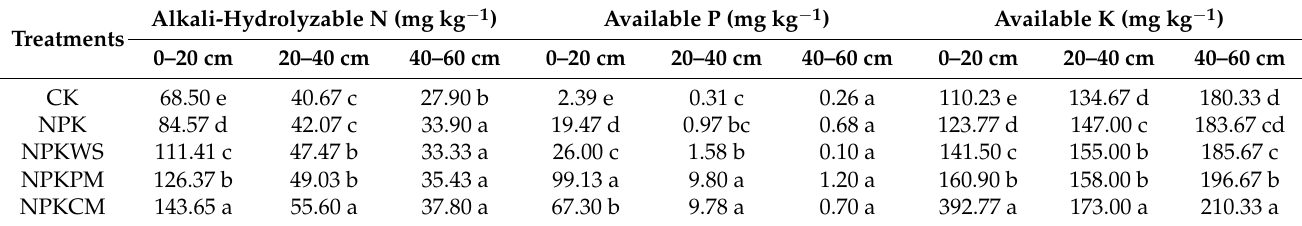
Table 2. Alkali-hydrolyzable N, available P and available K contents in the 0–20 cm, 20–40 cm and 40–60 cm depths after 32 years of fertilization in each treatment. CK: no fertilization; NPK: chemical fertilizers; NPKWS: NPK plus wheat straw; NPKPM: NPK plus pig manure; NPKCM: NPK plus cattle manure.